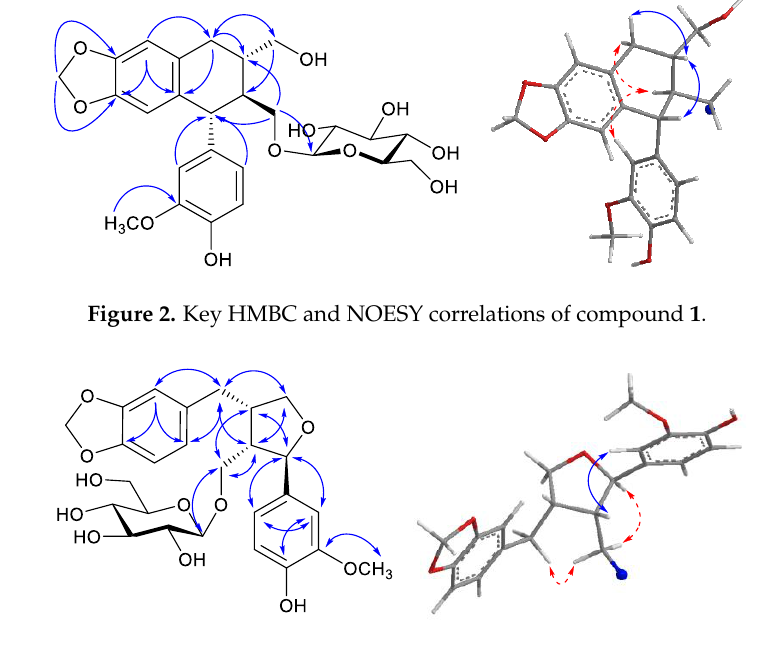
Figure 3. Key HMBC and NOESY correlations of compound 2 .